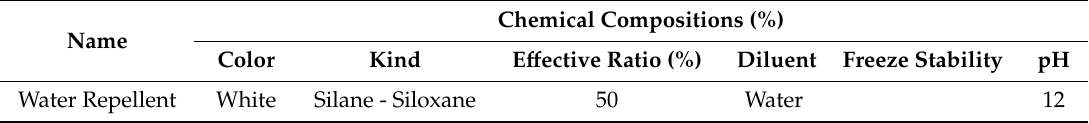
Table 4. Chemical compositions of water